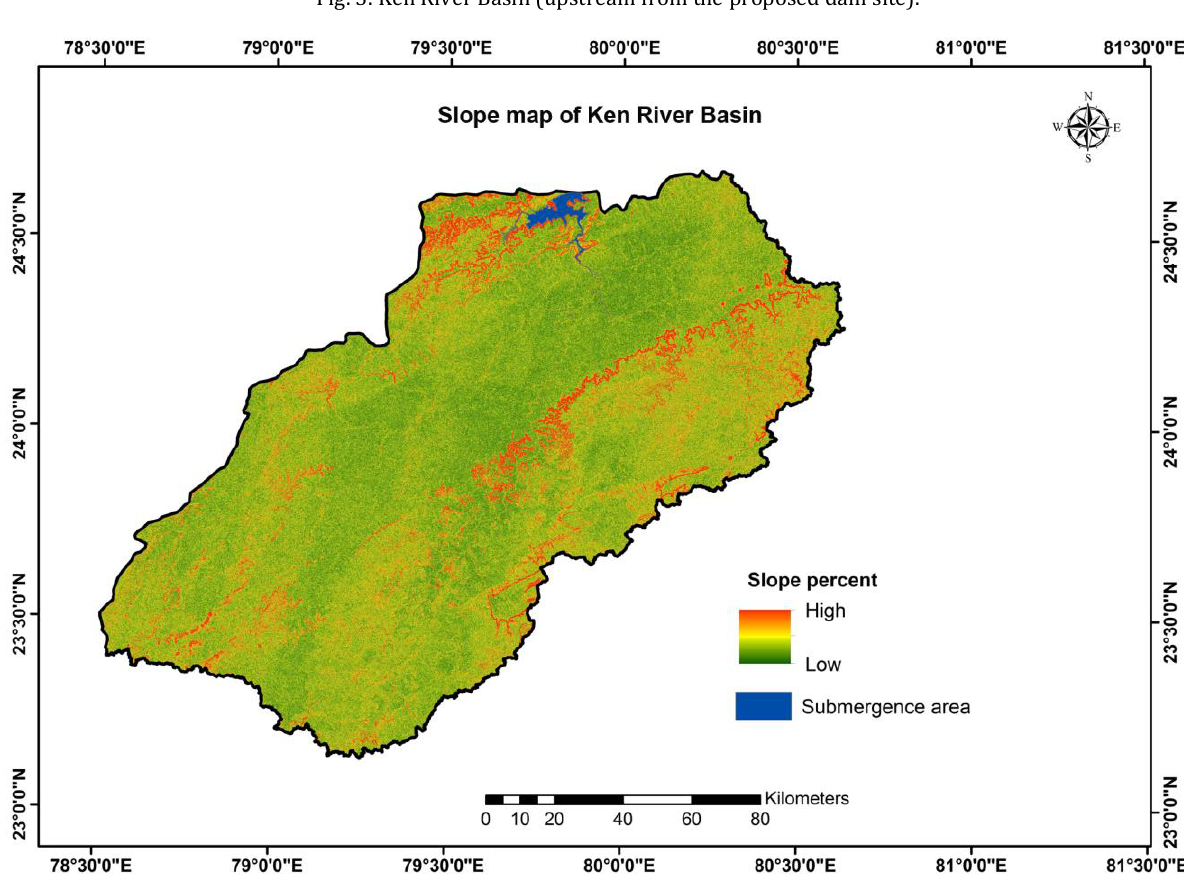
Fig. 4. Slope map of Ken River Basin (Upstream from the proposed dam